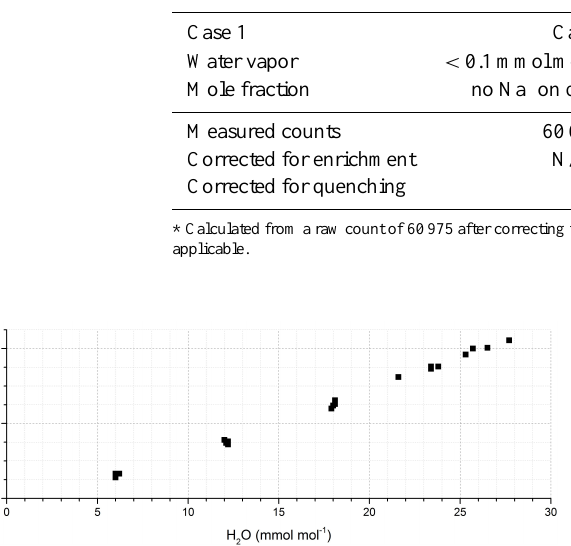
Table 1. Comparison of measured ozone signals (mean of 15min data) at 30nmolmol − 1 (in countss − 1 ) for cases 1, 2, and 3, before and after applying each correction term.